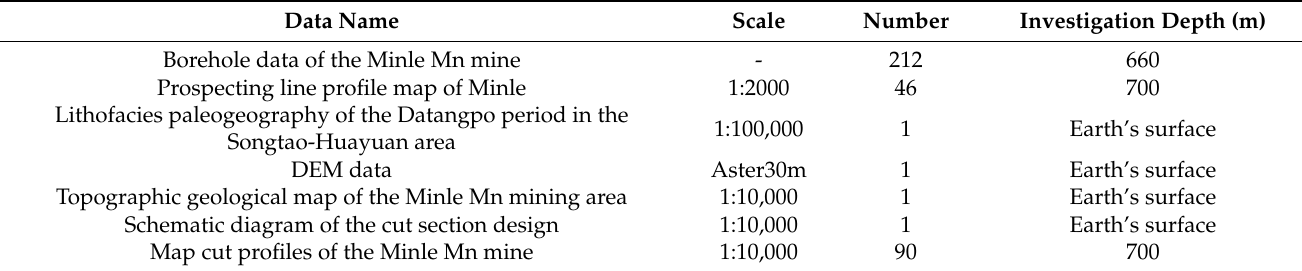
Table 4. The collected data in the 3D transfer learning area of